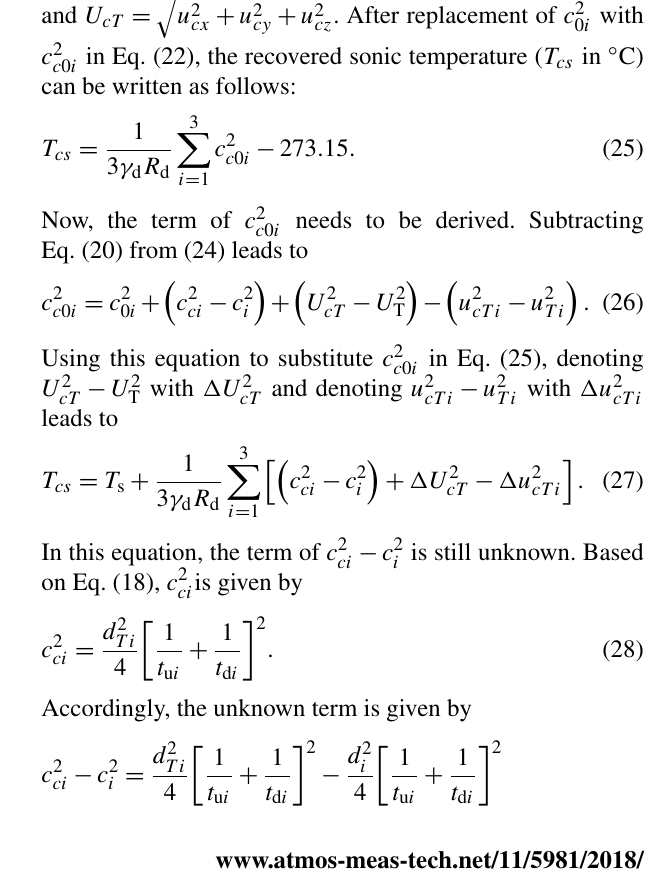
Figure 5. Crosswind on the speed of sound. Along the i th ( i = 1, 2, or 3) sonic path between the two sonic transducers, u i is the measured magnitude of flow vector whose true magnitude is u Ti , and c i is measured speed of sound; u ⊥ i is the crosswind vector normal to sonic path i ; U T is the magnitude of total flow vector whose magnitude is equal to speeds in the three-dimensional right-handed orthogonal anemometer coordinate systems; c 0 i is the speed of sound at crosswind equal to zero; and α i is the angle between sonic path i and the total flow